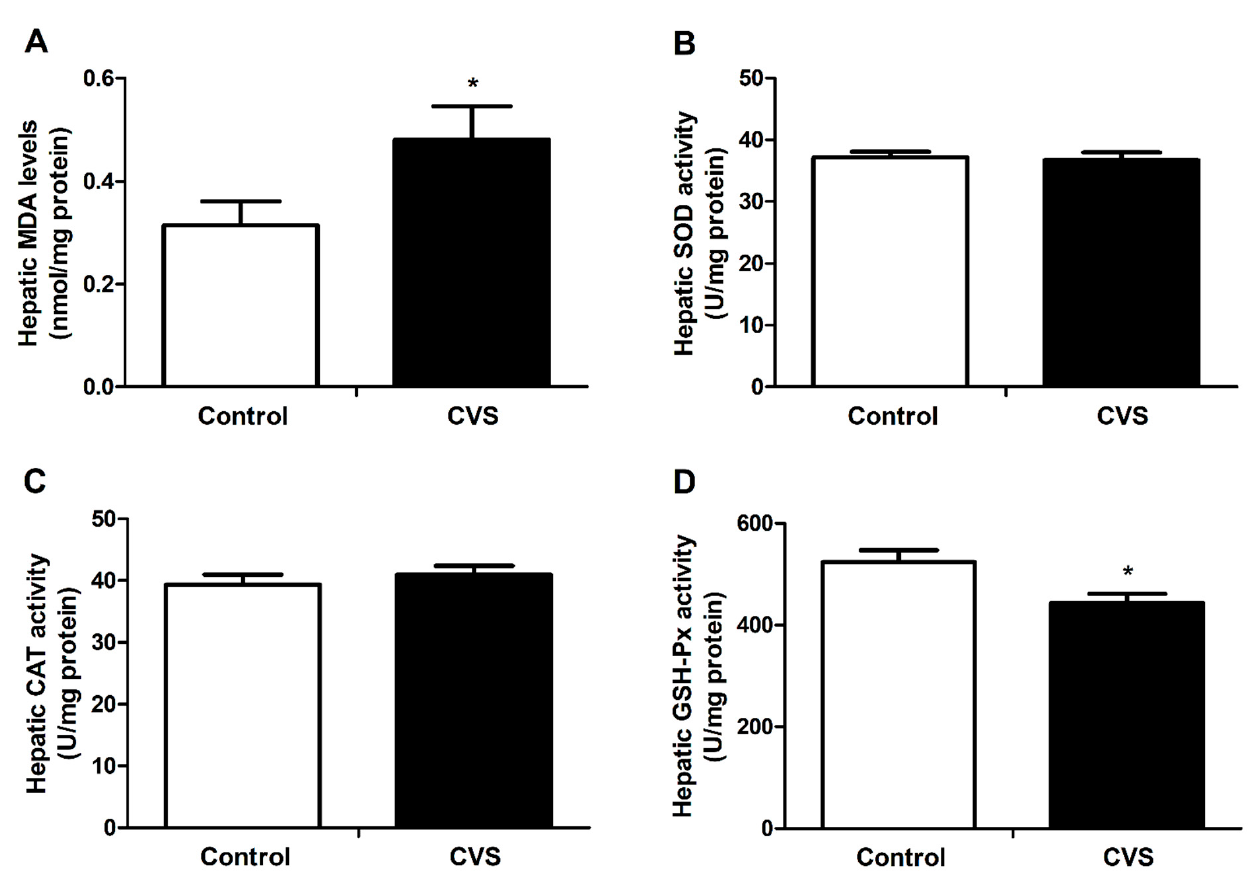
Figure 3. Effect of chronic variable stress on hepatic lipid peroxidation and antioxidant enzyme activities in rats. ( A ) The MDA level and ( B – D ) SOD, CAT and GSH-Px activities were determined as described in Materials and Methods. Con: control group; CVS: chronic variable stress group. Values were expressed as means ± SEM; n = 12 in each group. * p < 0.05.